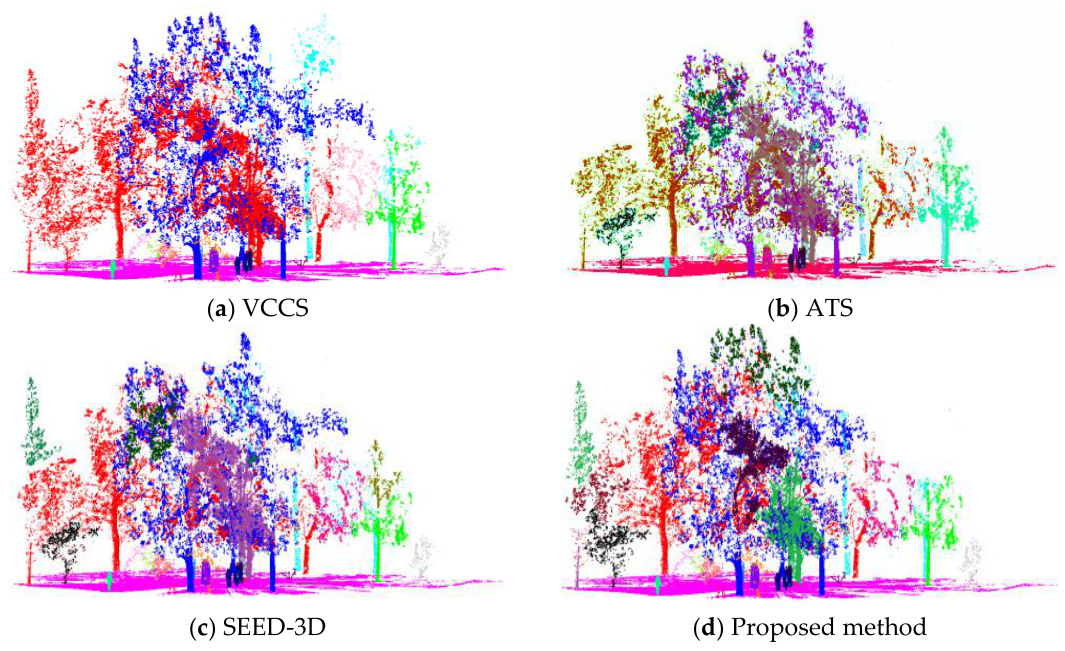
Figure 14. Comparison of segmentation results with the method of VCCS, ATS, SEED-3D in K-means clustering, and the proposed method in Gaussian density peak clustering.